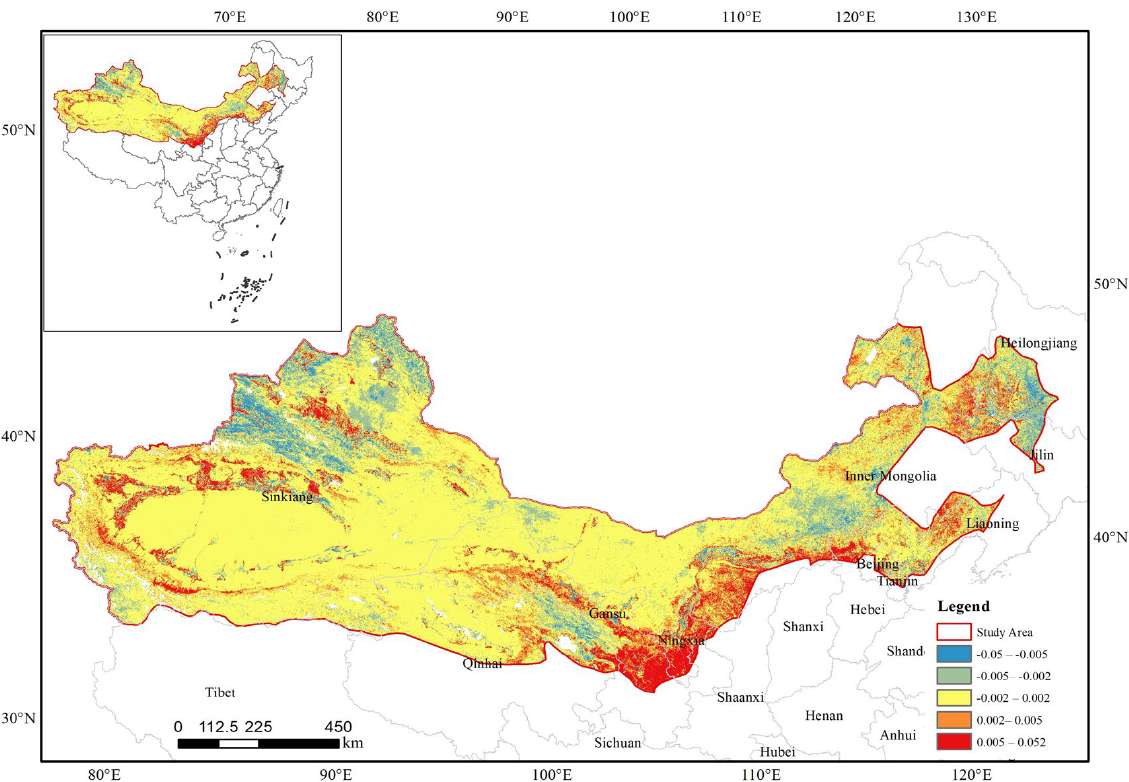
Figure 5. Trends in vegetation cover in the Three Norths Project area (less than −0.005 indicates significant decrease, −0.005~−0.002 indicates mild decrease, −0.002~0.002 indicates basically unchanged, 0.002~0.005 indicates mild increase, and greater than 0.005 indicates significant increase).